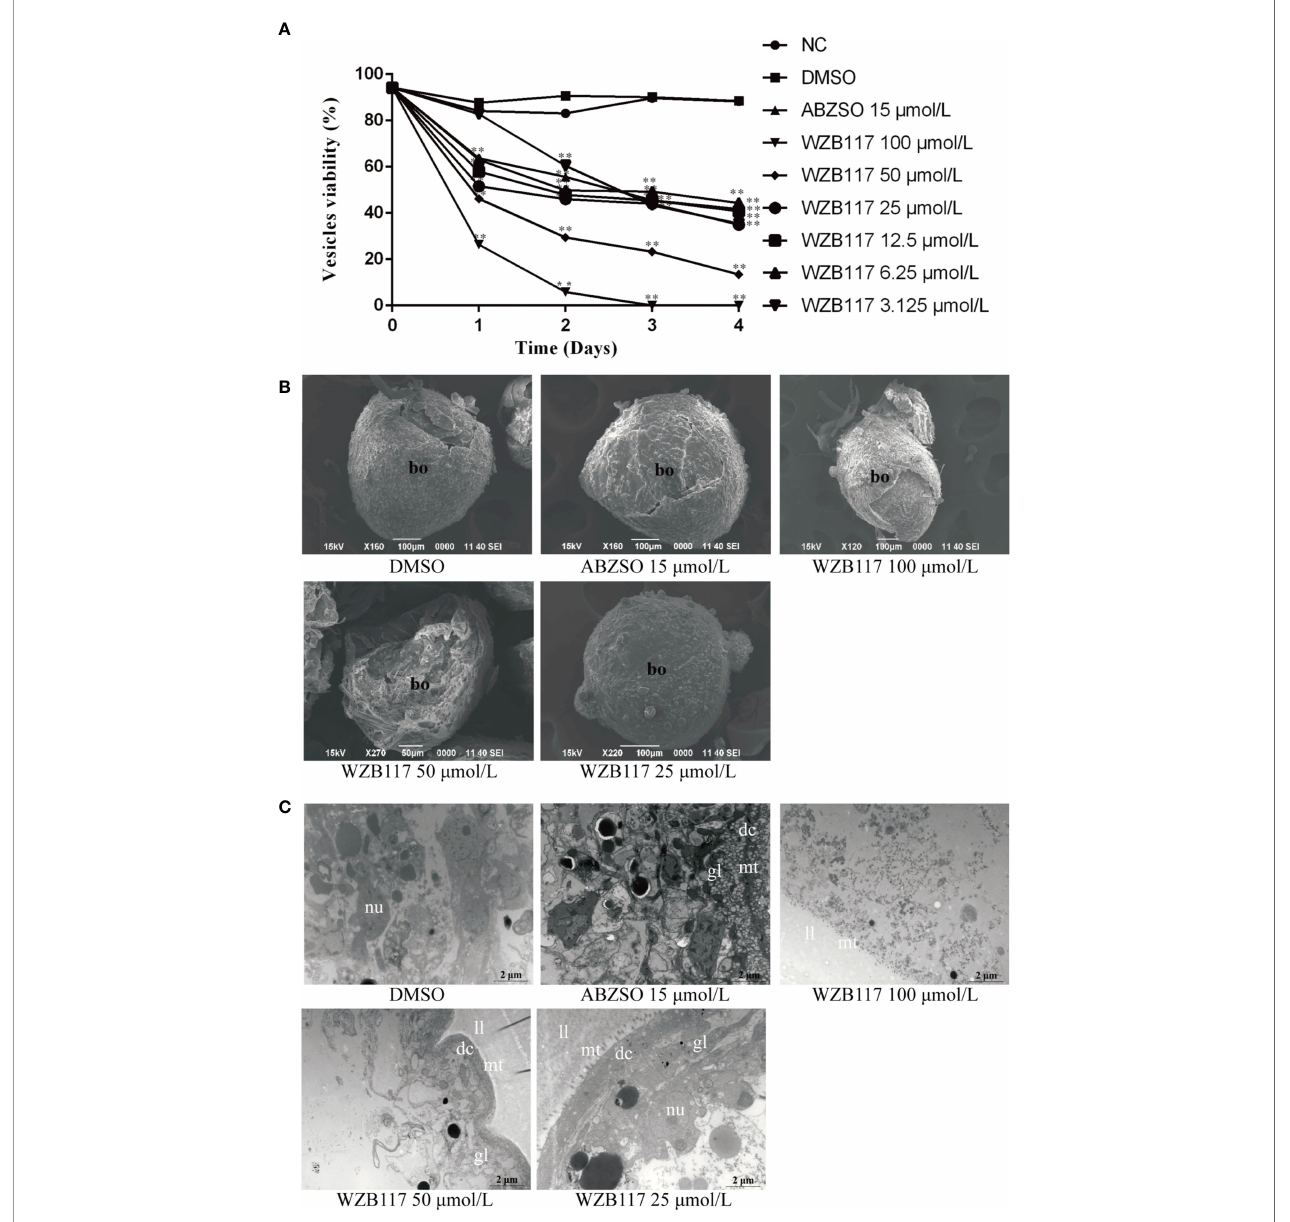
FIGURE 4 | WZB117 reduces the viability of E granulosus s.s. vesicles in vitro . (A) Vesicle viability of E granulosus s.s. after WZB117 incubation for 4 days. Each point represents the mean percentage of viable vesicles from three different experiments. * and ** show a statistically signi fi cant difference between the treatment group and the DMSO group at the indicated times (* P < 0.05, ** P < 0.01) (chi-square test). NC: negative control group; DMSO: control group; albendazole sulfoxide (ABZSO) at 15 m mol/L was used as a reference anti-infective agent. Data are the mean ± S.D. of three independent experiments. (B) Representative SEM images of vesicles after WZB117 incubation for 4 days. Vesicles incubated in culture medium containing DMSO served as a control. (C) Representative TEM images of vesicles after WZB117 incubation for 4 days. Vesicles incubated in culture medium containing DMSO served as a control. bo, body; gl, germinal layer; ll, laminated layer; mt, microtriches; nu,